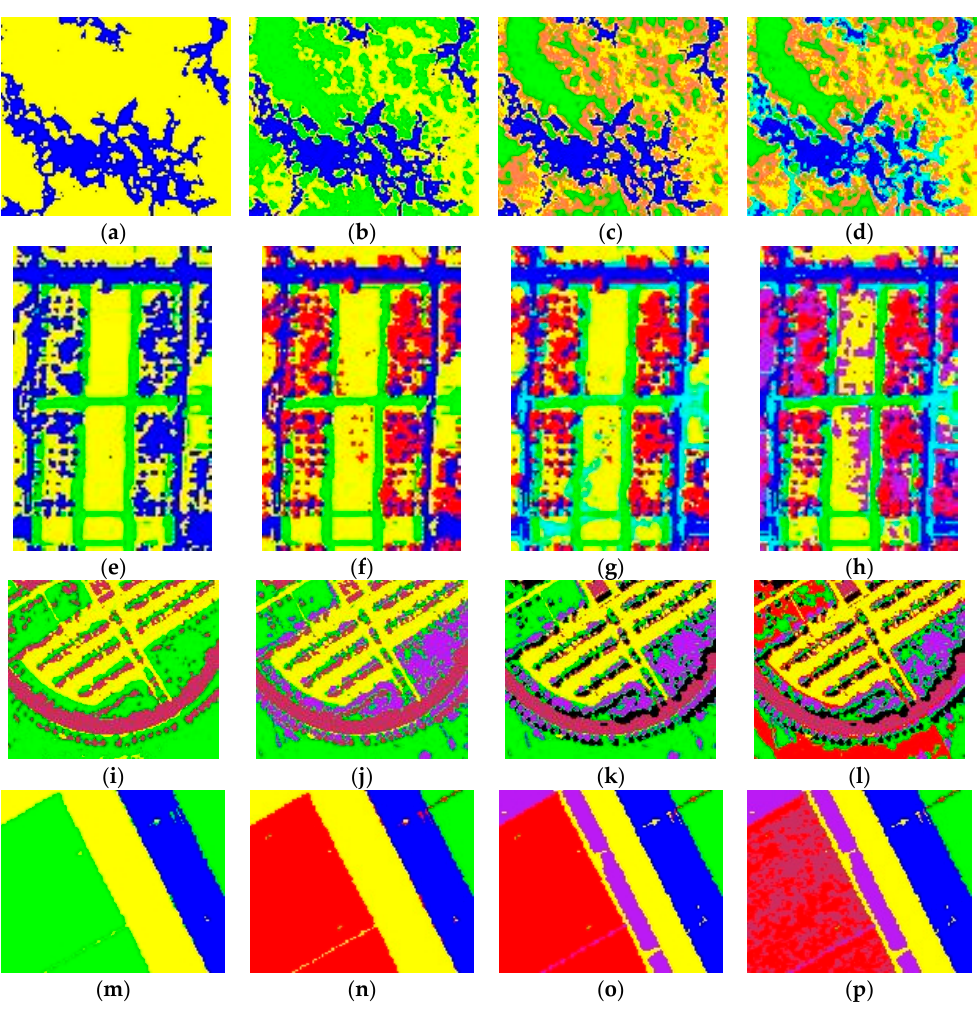
Figure 4. Clustering results of the hyperspectral images by FCM (each color represents a cluster). ( a )